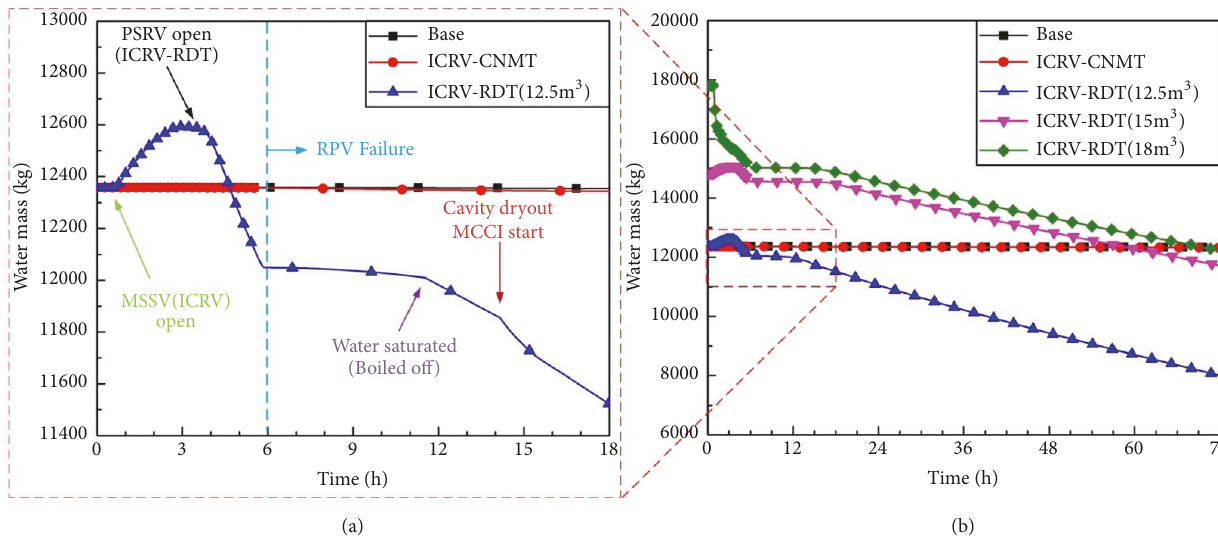
Figure 15: The water mass of the RDT in each case.